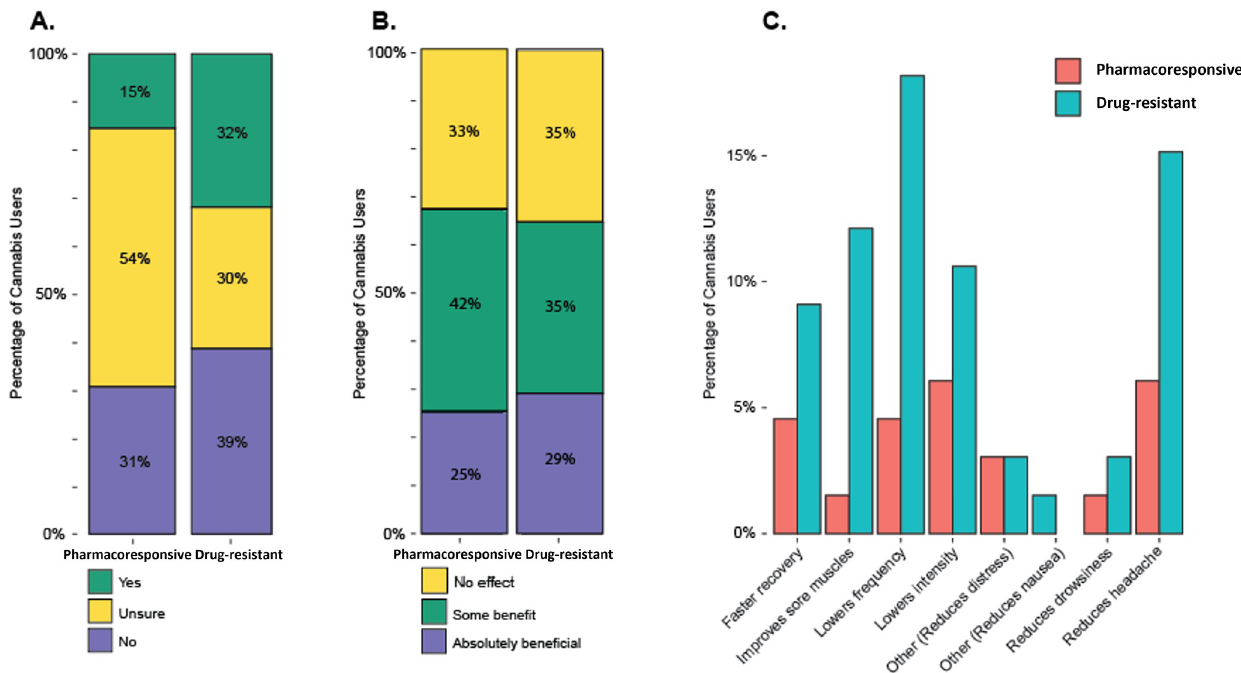
Fig 3. Reasons for cannabis use. 3a. Belief that cannabis affected epilepsy symptoms in patients with drug-resistant vs. pharmacoresponsive epilepsy. 3b. Perceived benefit of cannabis on seizure-related symptoms in patients with drug-resistant vs. pharmacoresponsive epilepsy. 3c. Differences in seizure- related symptoms that cannabis was perceived to help in patients with drug-resistant vs. pharmacoresponsive epilepsy.